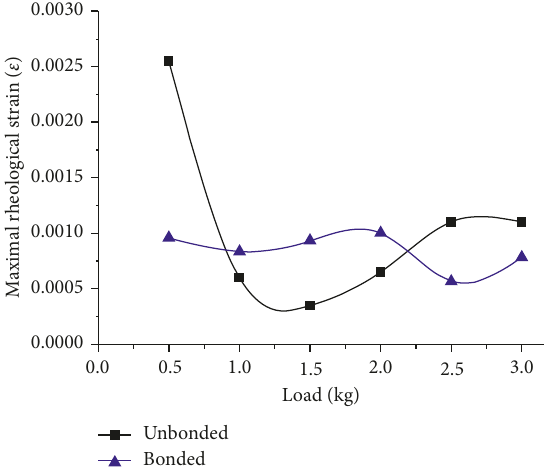
Figure 10: Comparison of rheological strain between the bonded and unbonded